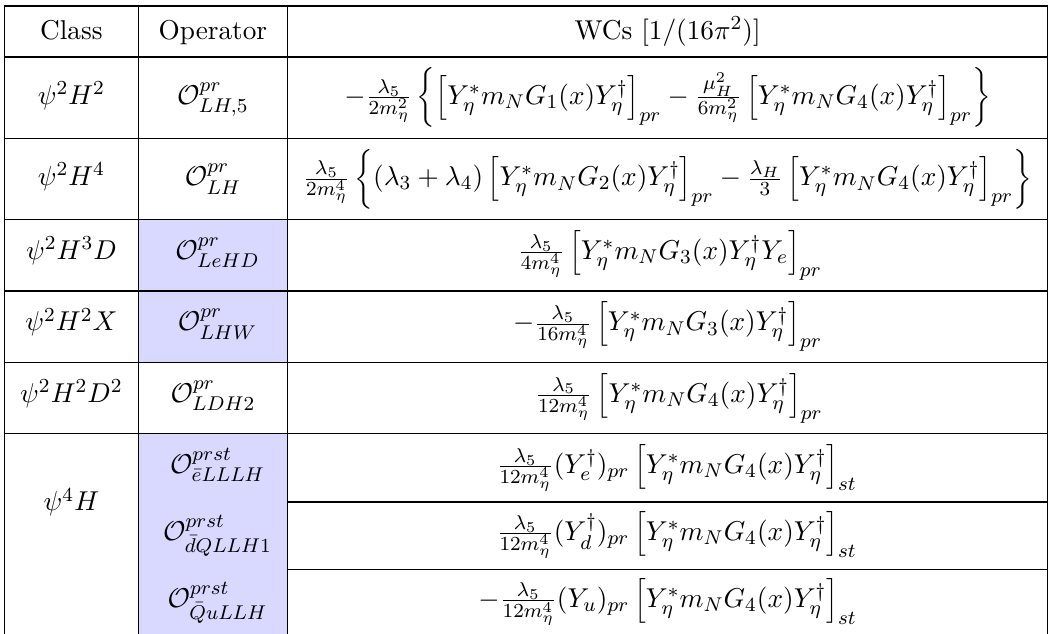
Table 3 . The matching result of dim-5 and dim-7 operators in the standard bases [25, 64]. Seven out of twelve dim-7 LNV but baryon-number-conserving operators are